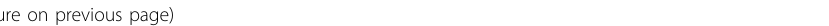
Fig. 2 Ndufs6 − / − -BM-MSCs exhibit increased cellular senescence. A The same number of BM-MSCs and Ndufs6 − / − -BM-MSCs was cultured, and cells counted and presented 2 days later. B The typical cellular morphology of BM-MSCs and Ndufs6 − / − -BM-MSCs was observed. C The cell area of BM-MSCs and Ndufs6 − / − -BM-MSCs was quanti fi ed. D SA- β -gal staining showing β -gal-positive cells in BM-MSCs and Ndufs6 − / − -BM-MSCs. E The β -gal positivity in BM-MSCs and Ndufs6 − / − -BM-MSCs was quanti fi ed by calculating the ratio of stained cells to total cells. F The proliferation of BM- MSCs and Ndufs6 − / − -BM-MSCs was assessed by Ki-67 staining. G The Ki-67 positivity in BM-MSCs and Ndufs6 − / − -BM-MSCs was quanti fi ed by calculating the ratio of stained cells to total cells. H The mRNA level of p53 and p21 in BM-MSCs and Ndufs6 − / − -BM-MSCs was determined by RT-PCR. I The protein level of p53 and p21 in BM-MSCs and Ndufs6 − / − -BM-MSCs was determined by western blotting. Results are presented as mean ± SD. n = 3. **p < 0.01; ***p <